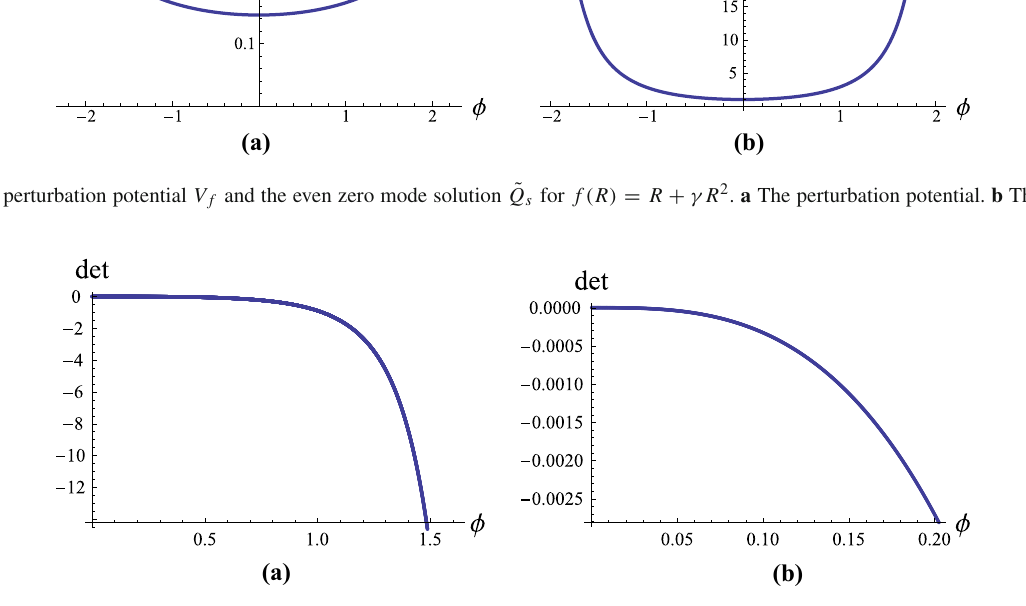
Fig. 2 The determinant of the solution matrix for f ( R ) = R + γ R 2 . a The determinant of the solution matrix. b Zoom in of a around φ = 0